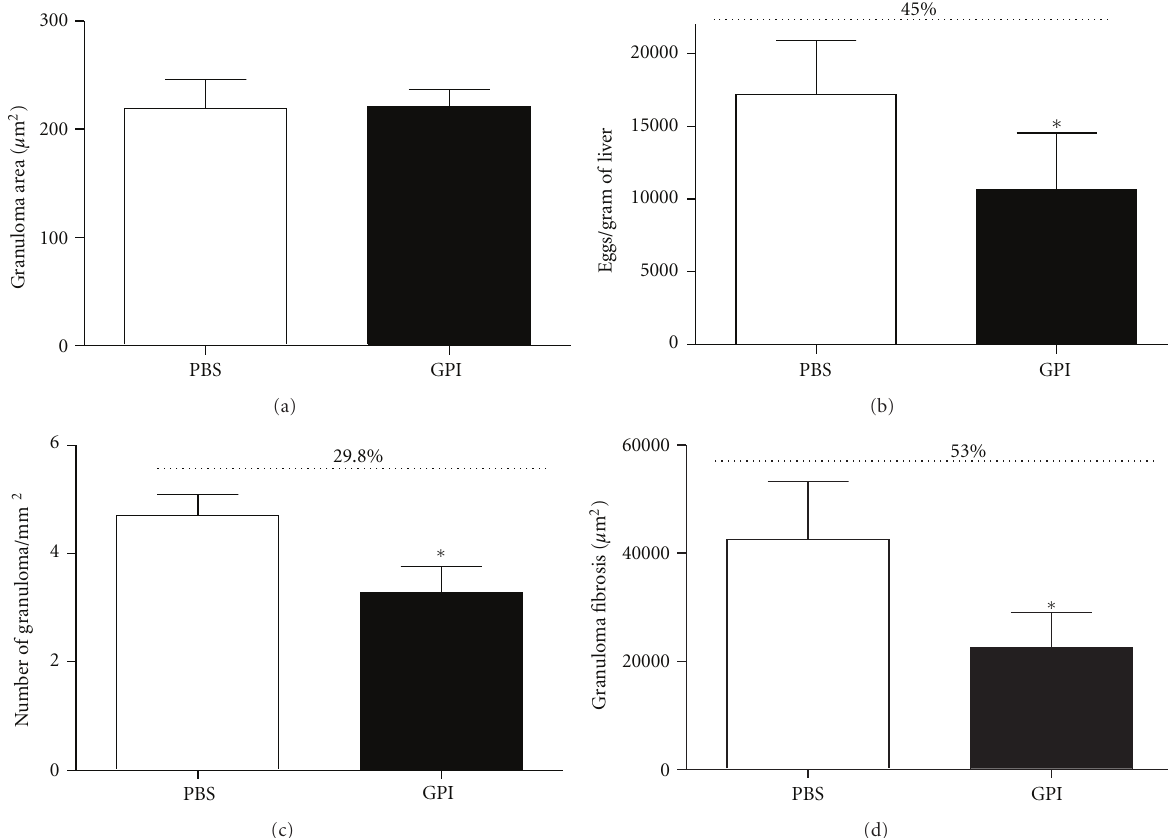
Figure 5: Liver pathology measured in mice vaccinated with GPI-anchored proteins. (a) Hepatic granuloma area, (b) Number of eggs per gram of hepatic tissue, (c) hepatic granuloma numbers, and (d) fibrosis area. The quantification of eggs and the number of granulomas in histological sections were performed using a microscope with 10x objective lens. The results are expressed in square micrometer for granuloma area, in eggs per gram of tissue for number of eggs, in granuloma per square milimeter for number of granuloma and fibrosis per square micrometer for granuloma fibrosis. A statistically significant di ff erence of GPI vaccinated mice compared to control group is denoted by an asterisk for P < 0 . 05. Results are representative of two independent biological